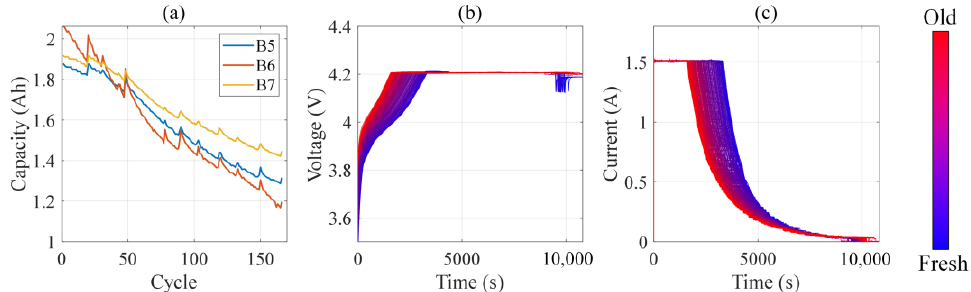
Figure 2. Details of the NASA dataset: ( a ) capacity degradation curves; ( b ) voltage curves of B5; ( c ) current curves of B5.